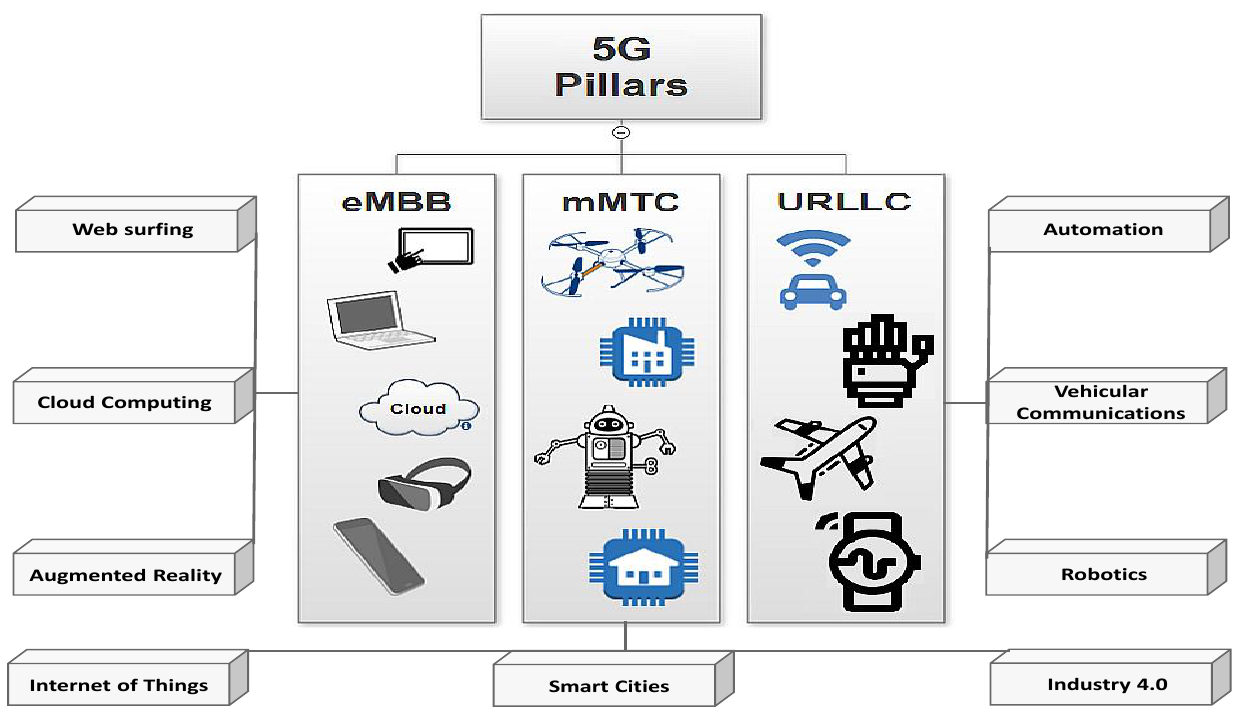
Figure 3. The fifth-generation network’s pillars with examples of each of